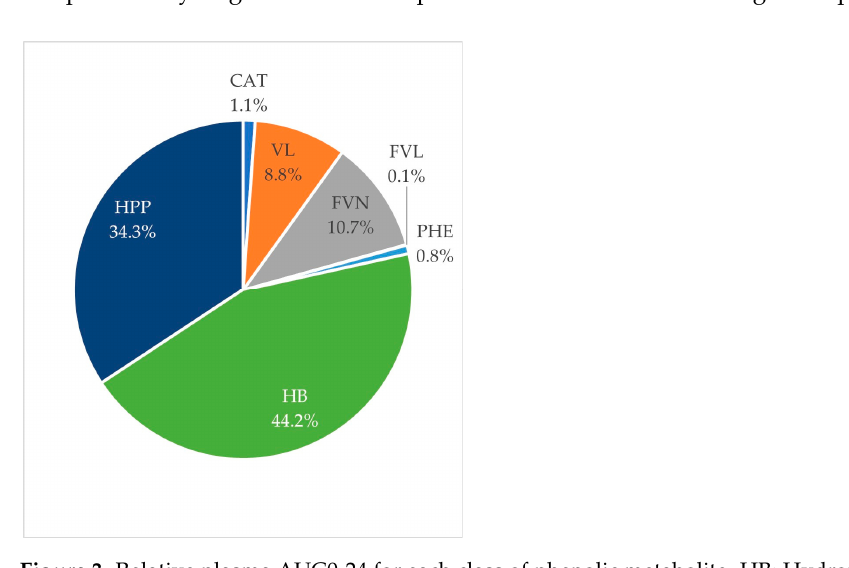
Figure 3. Relative plasma AUC0-24 for each class of phenolic metabolite. HB: Hydroxybenzoic acids and simple benzenes; HPP: Hydroxyphenylpropanoic acids; FVN: flavanone derivatives; VL: Phenyl y-valerolactones and phenyl valeric acids; CAT: (Epi)catechin derivatives; PHE: Phenylethanoid derivatives; FVL: Flavonol derivatives. 4 (cid:48) -hydroxyhippuric acid was not included. Two main subclasses of flavan-3-ol derivatives were identified: (epi)catechin phase-II conjugates and phenyl-y-valerolactone and phenylvaleric acid derivatives. Among